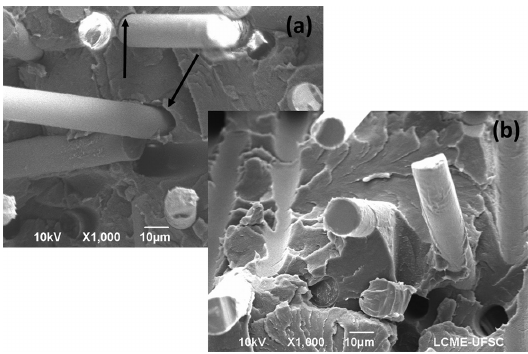
Figure 4: SEM micrograph (x1,000) of aged (a) and virgin (b) samples, indicating the first poorer interfacial bonding between fibers and matrix.